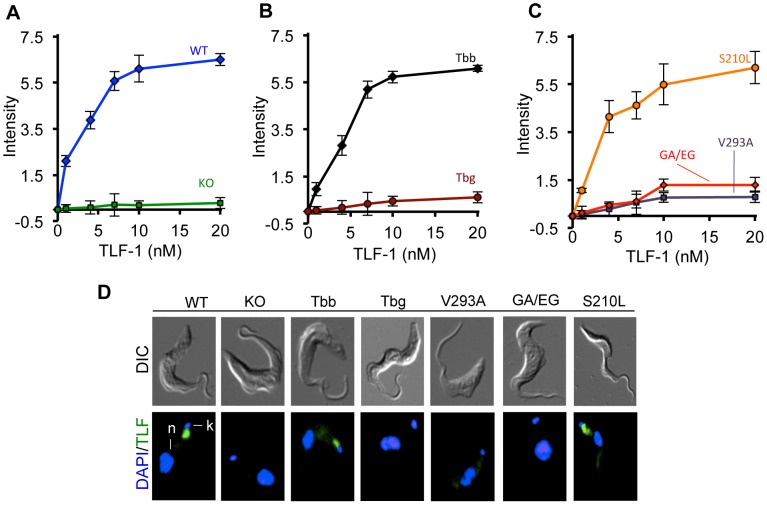
Saturation binding studies with TLF-1.(A) Binding affinities were estimated based on half-maximal binding at 3°C with varying concentrations of Alexa-488 TLF-1. Binding to T. b. brucei (WT) and TbbHpHbR−/− (KO); (B) TbbHpHbR−/− cells ectopically, TbbHpHbR (Tbb) and TbgHpHbR (Tbg); and (C) TbbHpHbR−/− cells ectopically expressing TbgHpHbRV293A (V293A), TbgHpHbRGA369/370EG (GA/EG) and TbgHpHbRS210L (S210L). Affinities for the Alexa-488 TLF-1 with WT were Kd = 3.96±0.31 nM, Tbb Kd = 4.12±0.25 nM, S210L Kd = 3.96±0.35 nM. No binding was observed for Tbg, KO, V293A or GA/EG cell lines. (D) Fluorescence microscopy showed that Alexa-488 TLF-1 binding was seen in the flagellar pocket of WT, Tbb and S210L. Kinetoplast (k), Nucleus (n).